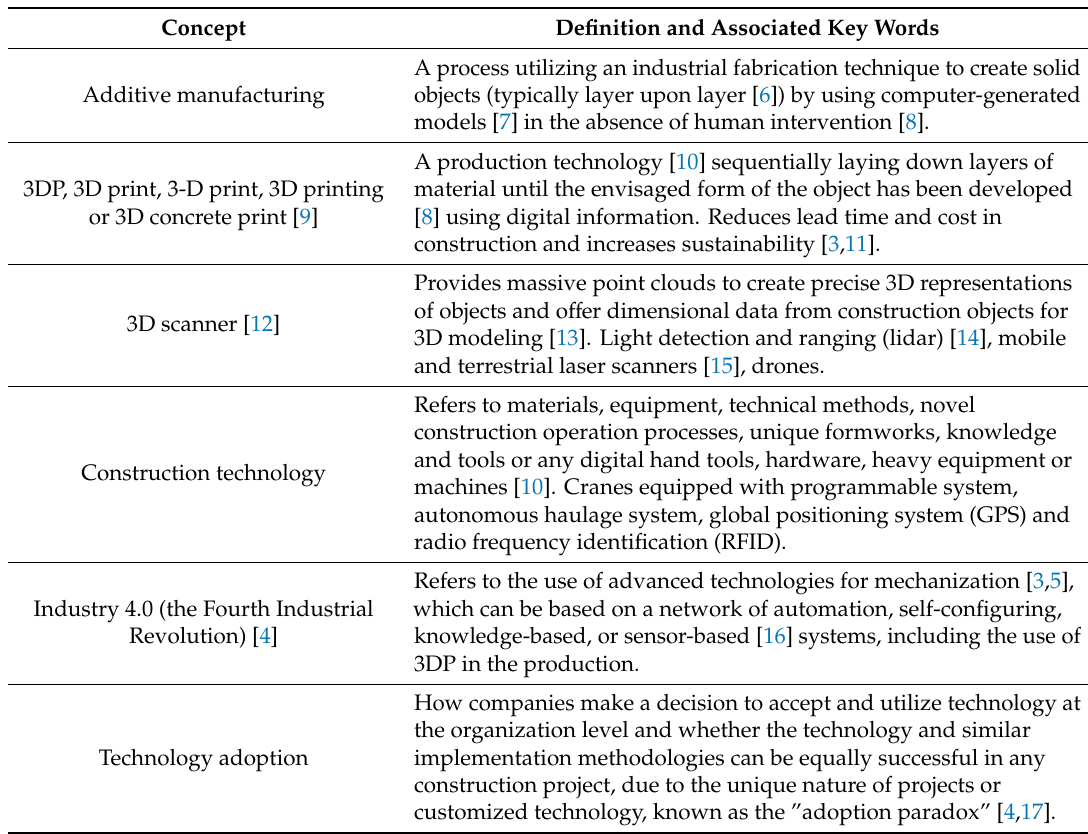
Table 1. Summary of definitions for consistency throughout this